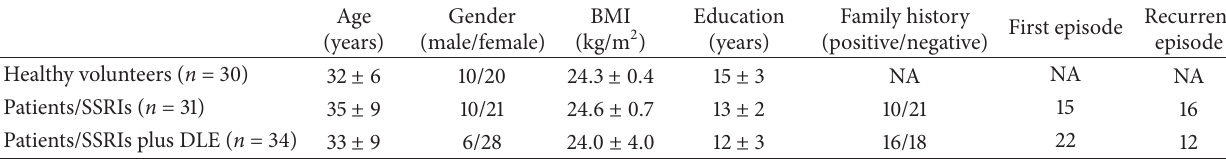
Table 1: Demographic characteristics in depressed subjects and healthy